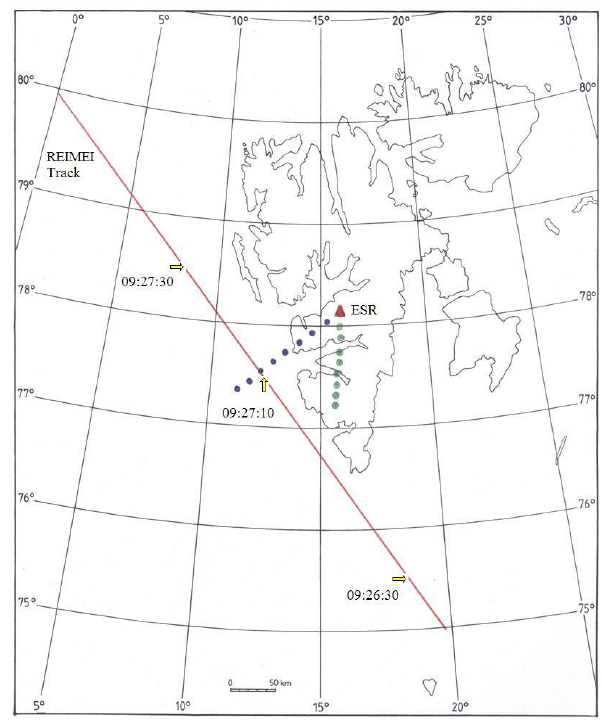
Fig. 1. Map showing the REIMEI trajectory projection and the ESR beams. The times marked on the satellite trajectory are in UT. The beams for the 42- and 32m antenna are marked by green and blue circles, respectively. The circles are at 100km intervals in